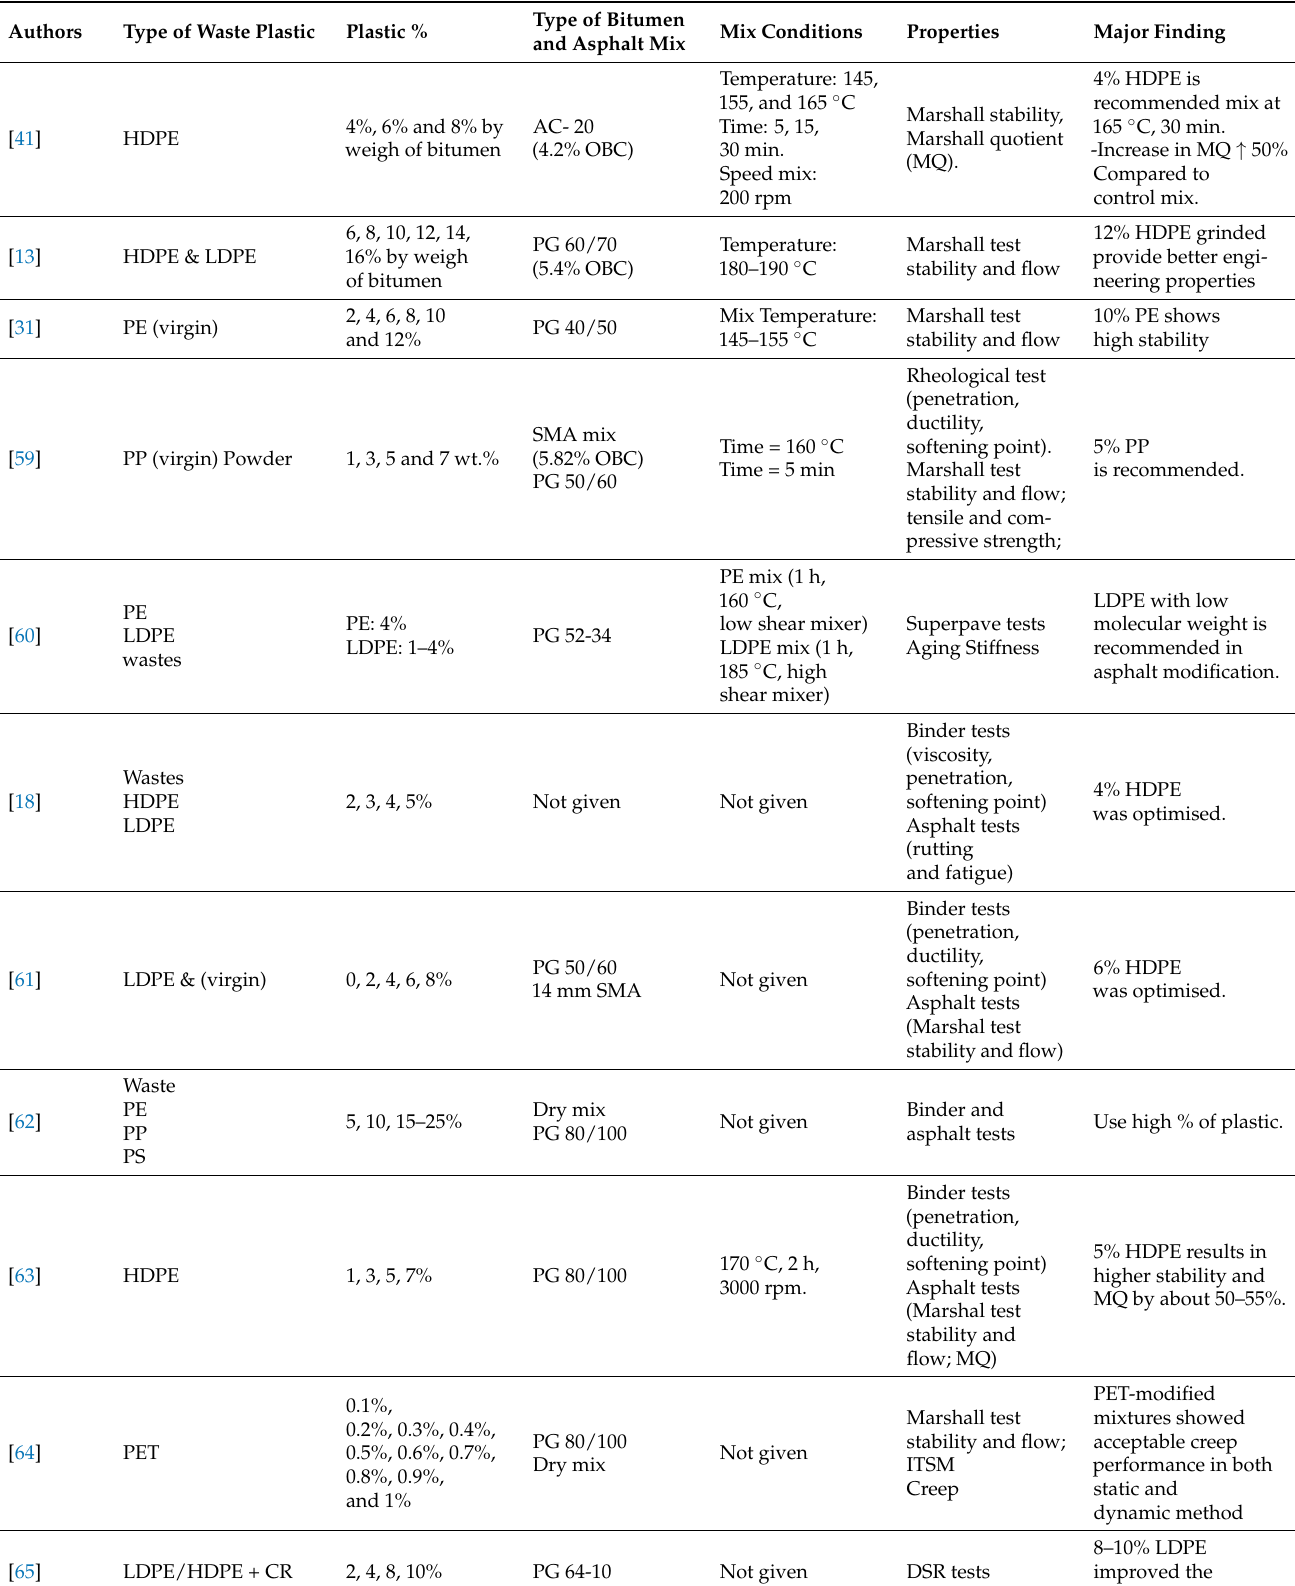
Table 3. Properties of asphalt mix using plastic obtained from previous